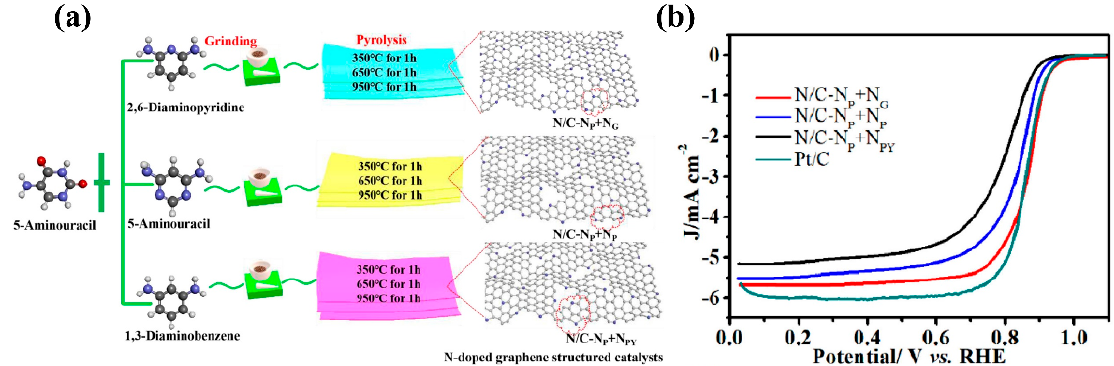
Figure 2. ( a ) Scheme of the synthesis process of precursor–modulated N–doped carbon materials; ( b ) linear scanning voltammetry curves for obtained materials. Adapted from [61], with permission from Electrochimica Acta , 2021.